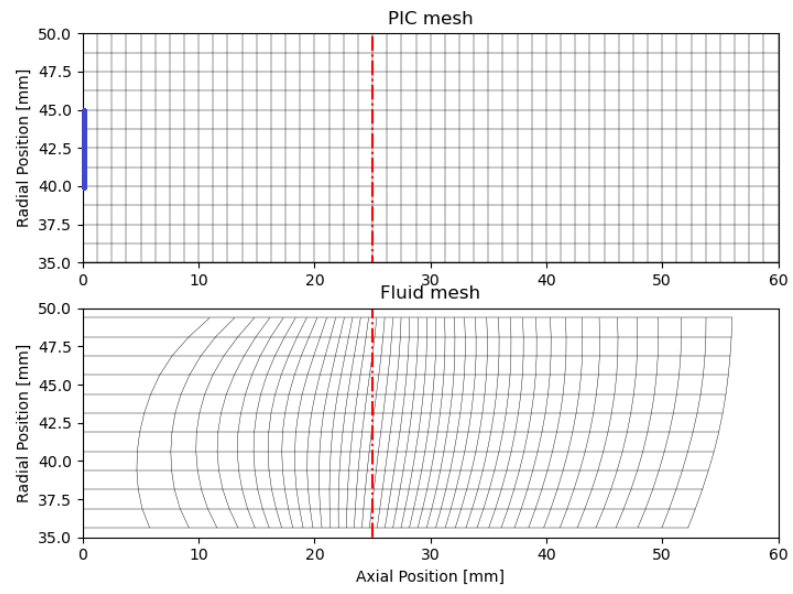
Figure 7. PIC (49 × 13) and fluid meshes (42 × 13). Blue line denotes the anodic inlet of Xenon